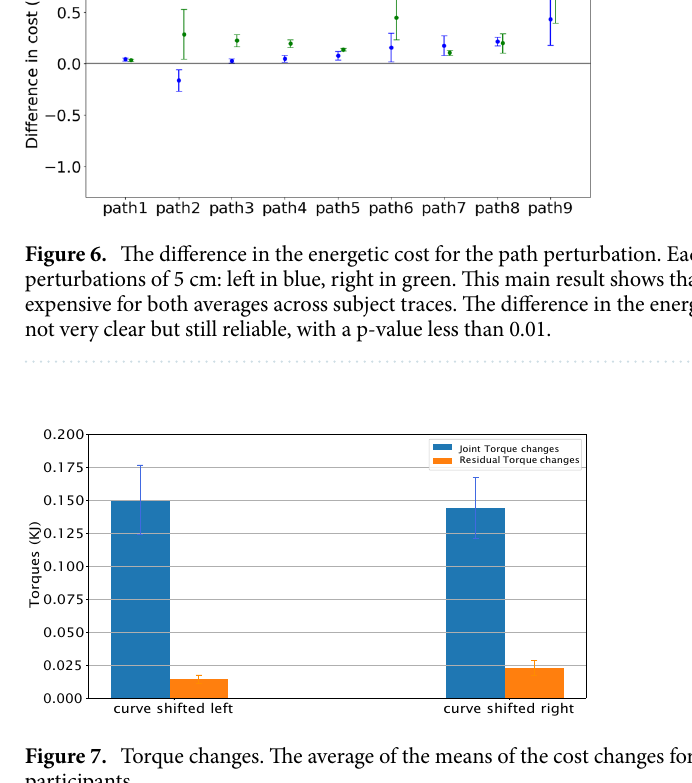
Figure 7. Torque changes. The average of the means of the cost changes for path 1 with five repeats across five